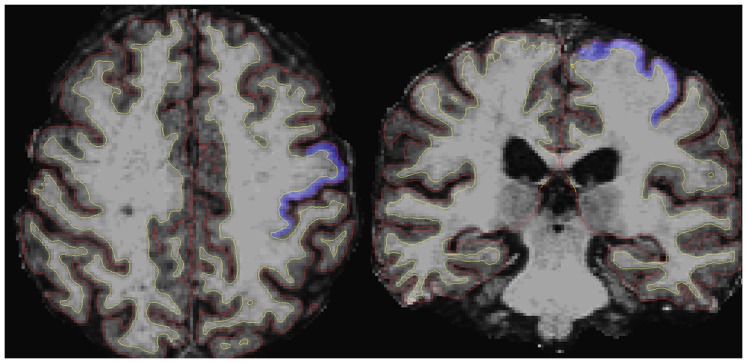
Example of the CTh boundaries of an ALS patients.Axial and coronal T1-weighted images of an ALS patient. White matter surface (yellow line) and pial surface (red line), which are the boundaries of cerebral cortex, have been automatically obtained by Freesurfer. The primary motor area (blu) has been automatically labeled according to the Desikan/Killiany Atlas.